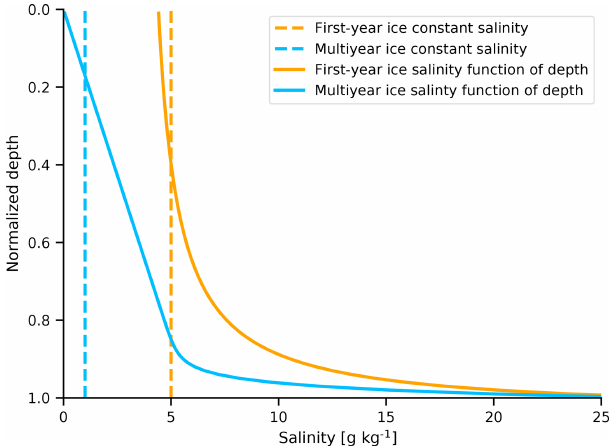
Figure 5. Salinity profiles used for the simplified profiles in Sect. 4.2.2. The dashed lines represent the constant salinity profiles and the solid lines represent the salinity profiles as a function of depth. The colors represent the different ice